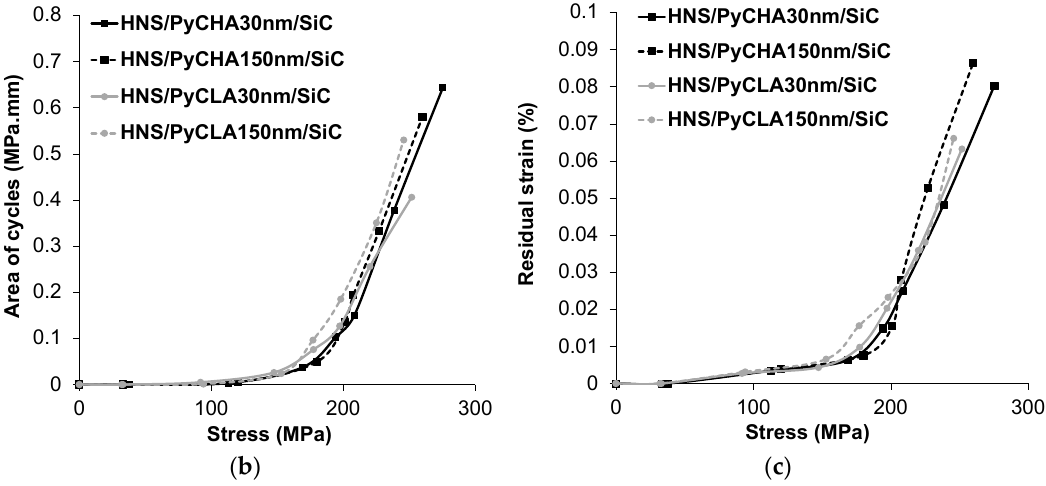
Figure 10. Evolution of ( a ) reduced modulus (E/E 0 ), ( b ) the area of cycles ( ∆ W) and ( c ) the residual strain ( ε r ) as a function of the maximum applied stress before unloading for all composites.